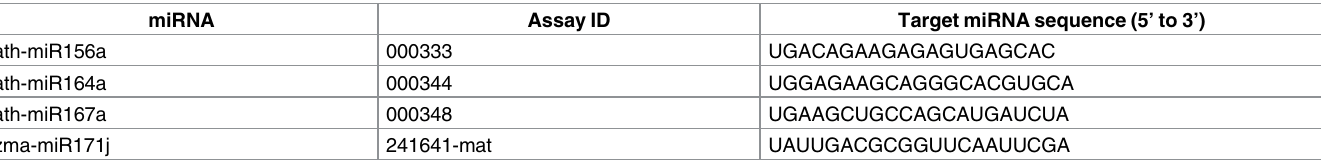
Table 2. TaqMan MicroRNA